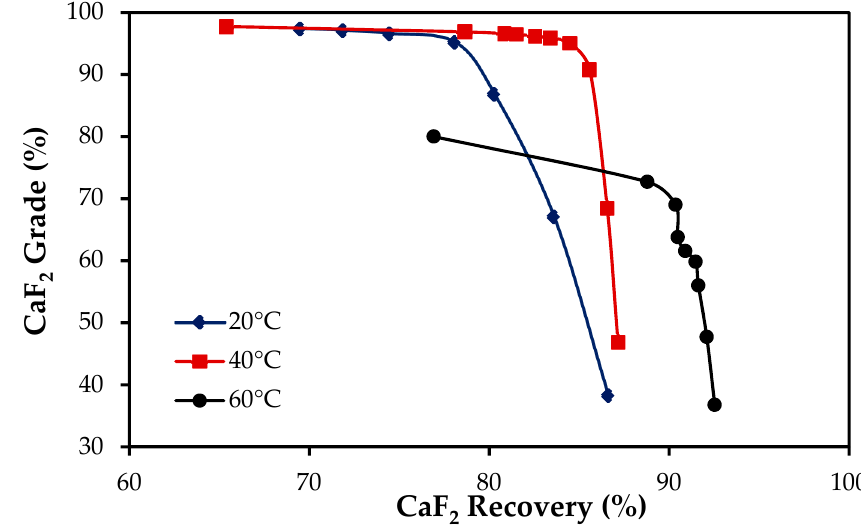
Figure 5. E ff ect of pulp temperature on CaF 2 grade–recovery relationship for ore B. Figure 5. Effect of pulp temperature on CaF 2 grade–recovery relationship for ore B.